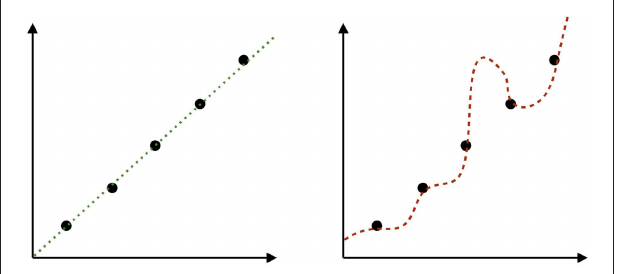
FIGURE 2 | There are an infinite set of possible functions interpolating from seen points to unseen points in these graphs. Our intuition is that the linear function on the left represents a more reasonable hypothesis than the one on the right, despite the fact that both fit the data perfectly well. In other words, we have prior expectations about what functions are more likely than others. In this case, the prior includes a preference for linearity (cf. Kalish et al.,